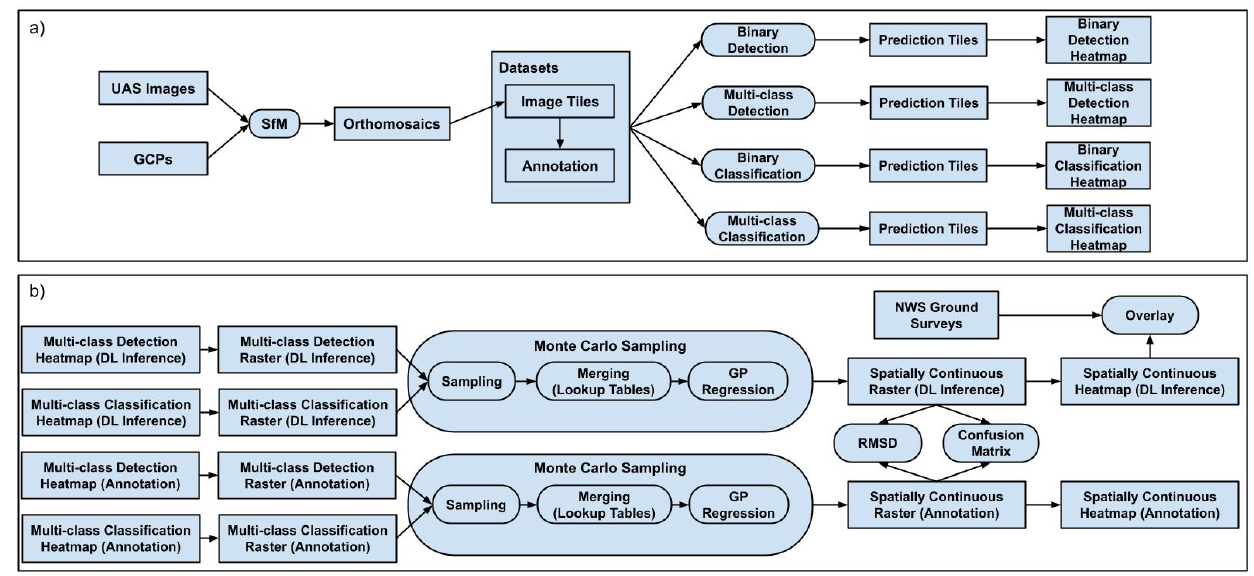
Figure 3. Workflow diagrams of ( a ) deep learning and ( b ) Gaussian process (GP) regression.